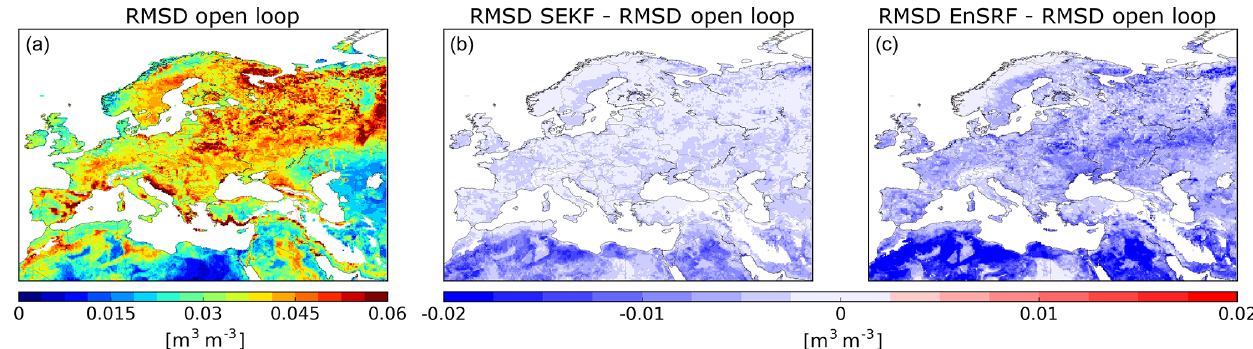
Figure 7. (a) Root mean square difference (RMSD) between observed (rescaled) SSM and its open-loop equivalent for the period 2008–2017 and RMSD difference between assimilation experiments (SEKF in b and EnSRF in c ) and the open loop.